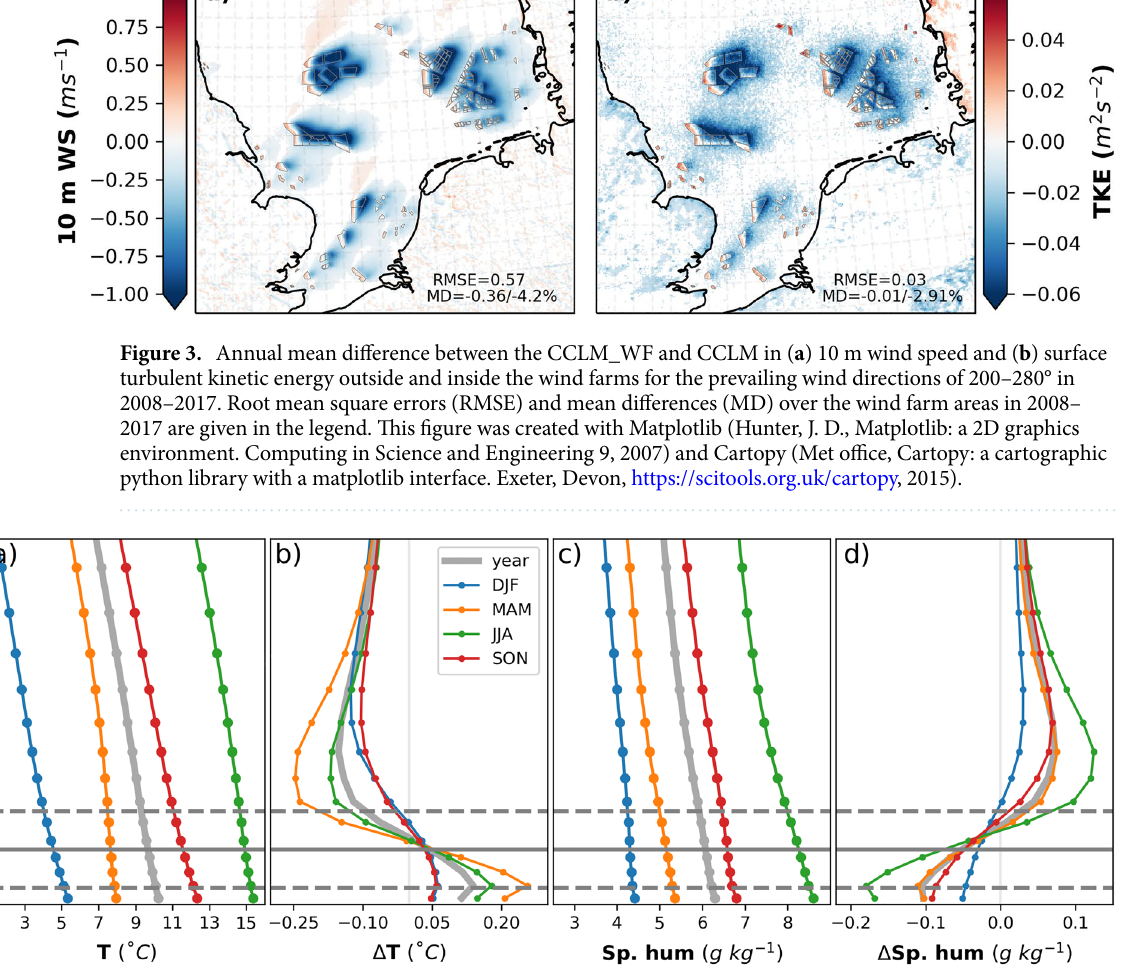
Figure 4. Mean vertical profiles of the CCLM for ( a ) temperature and ( c ) specific humidity and differences between the CCLM_WF and CCLM in vertical profiles of the ( b ) temperature and ( d ) specific humidity over the wind farm areas in 2008–2017. Solid circles indicate the model’s main levels ( a ) or half levels ( b ). The solid gray line indicates the hub height (90 m) of the turbine, whereas dotted gray lines indicate the lower (27 m) and upper (153 m) tips of the